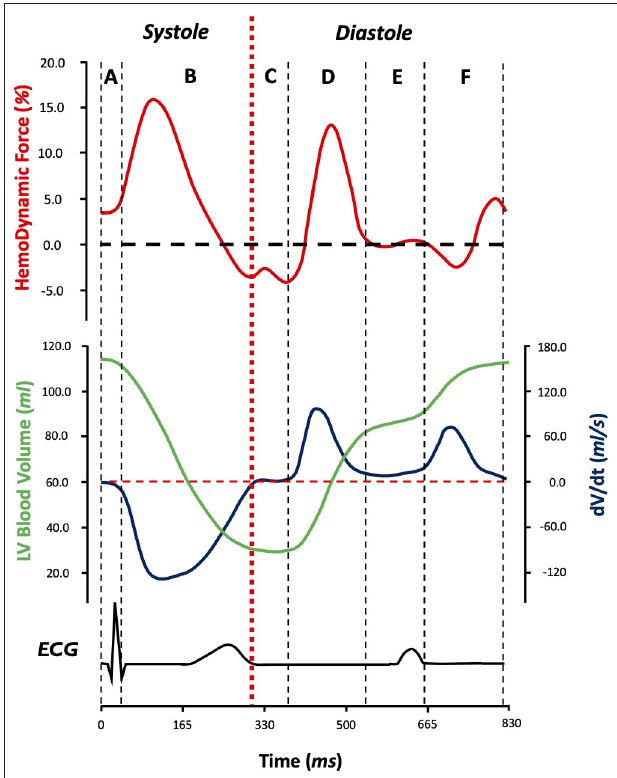
FIGURE 1 | Longitudinal hemodynamic force pattern (red) in relation to left ventricular blood volume (green), left ventricular blood volume change velocity (blue), and electrical activity during the cardiac cycle (black) during the six phases of the cardiac cycle (A–F) : isovolumic contraction (A) , systolic ejection (B) , isovolumic relaxation (C) , early diastolic filling (D) , diastasis (E) , and late diastolic filling (F) . By convention, when the HDF vector is directed from the apex to base of LV (when apical pressure is higher than basal pressure), it is considered to be positive (above the zero line) and when the HDF vector is directed from the base to apex (basal pressure higher than apical pressure), it is considered to be negative (below the zero line). DLF is described by root mean square of the diastolic segment of longitudinal hemodynamic forces. ECG, electrocardiography; LV, left ventricle; DLF, diastolic longitudinal force. dV/dt, derivative of volume as a function of time (left ventricular blood volume change velocity).